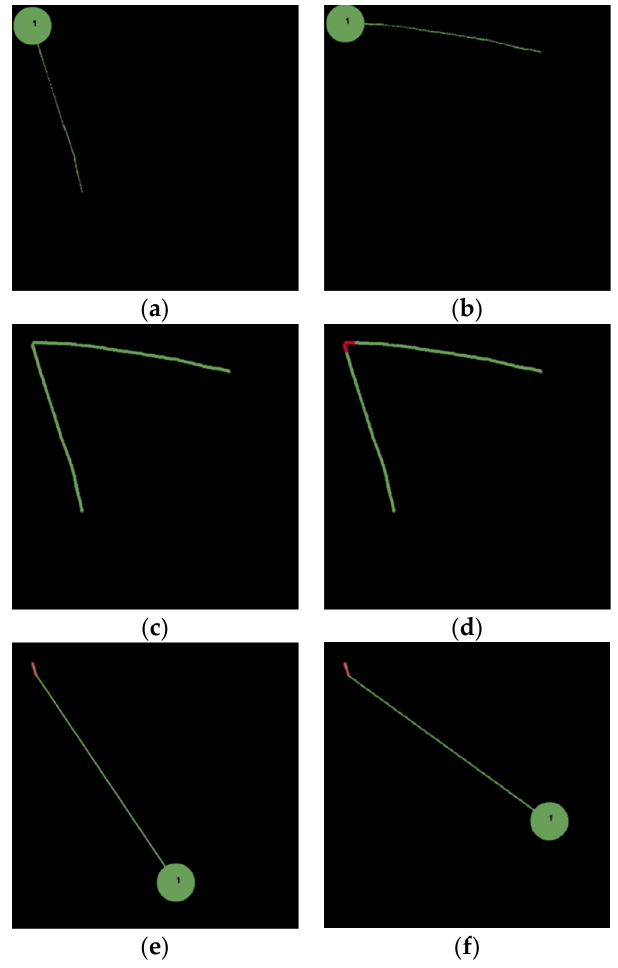
Figure 5. ‘Pick & place’ a green circle at the top left corner. ( a ) The first demonstration path. ( b ) The second demonstration path. ( c ) Absolute trajectory (type-1) through two demonstrations. ( d ) Key path of the absolute trajectory (type-1). ( e , f ) Planned path based on the key path.